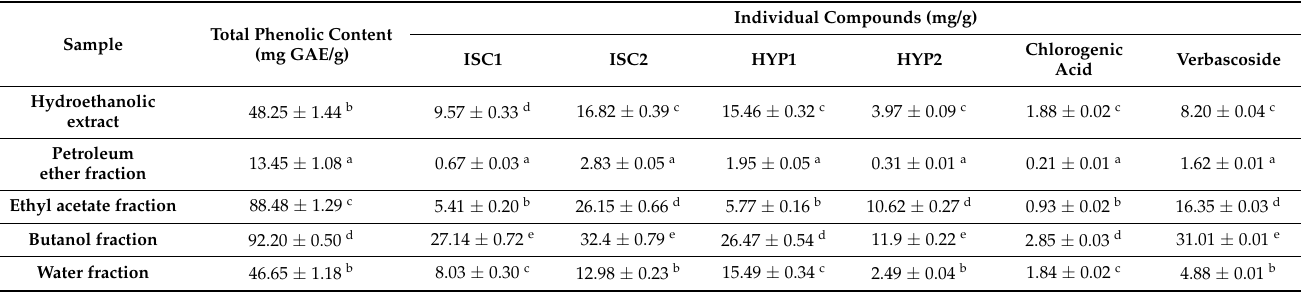
Table 1. Content of total phenolic and individual compounds in Sideritis raeseri subsp. raeseri aerial parts hydroethanolic extract and its